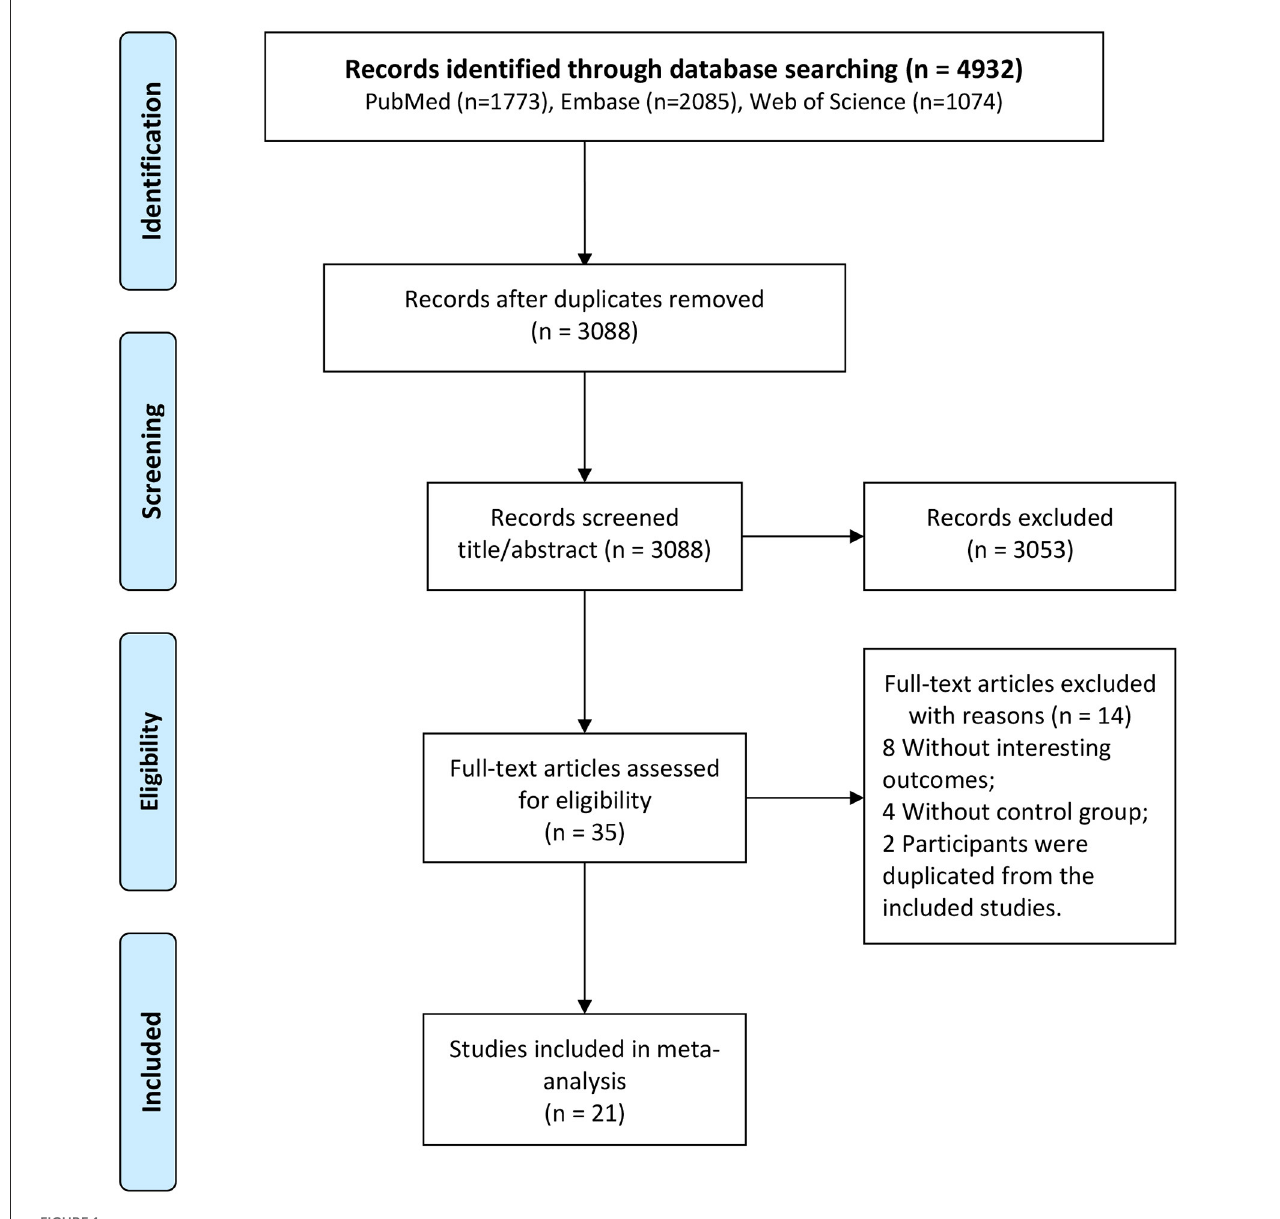
FIGURE1 Study selection